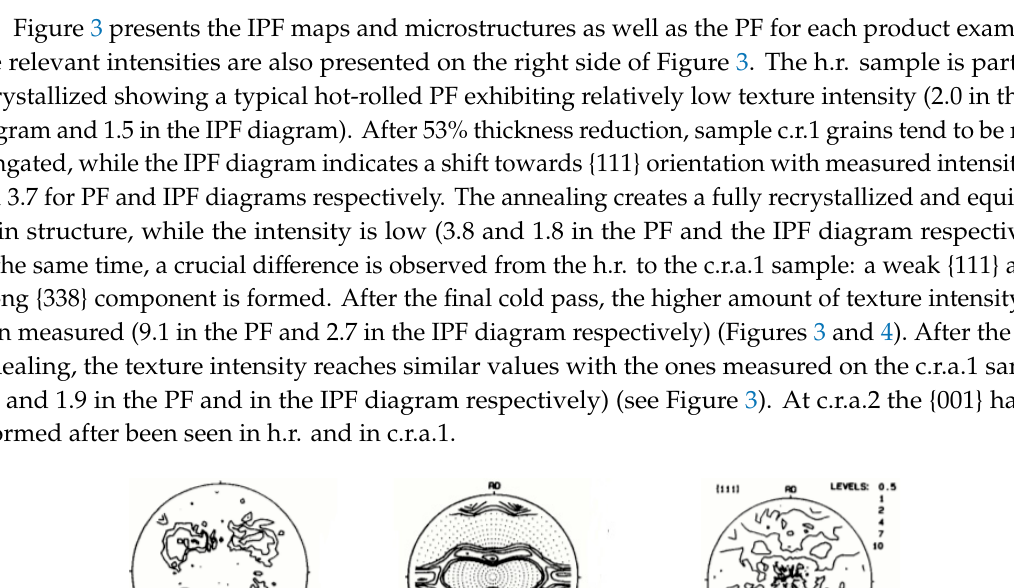
Figure 3. Electron back-scatter diffraction (EBSD) data for the examined products.